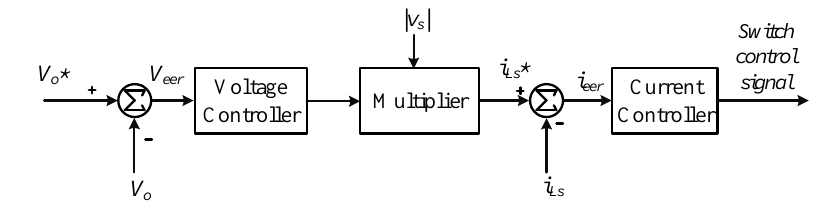
Figure 11. Conventional dual loop control scheme.